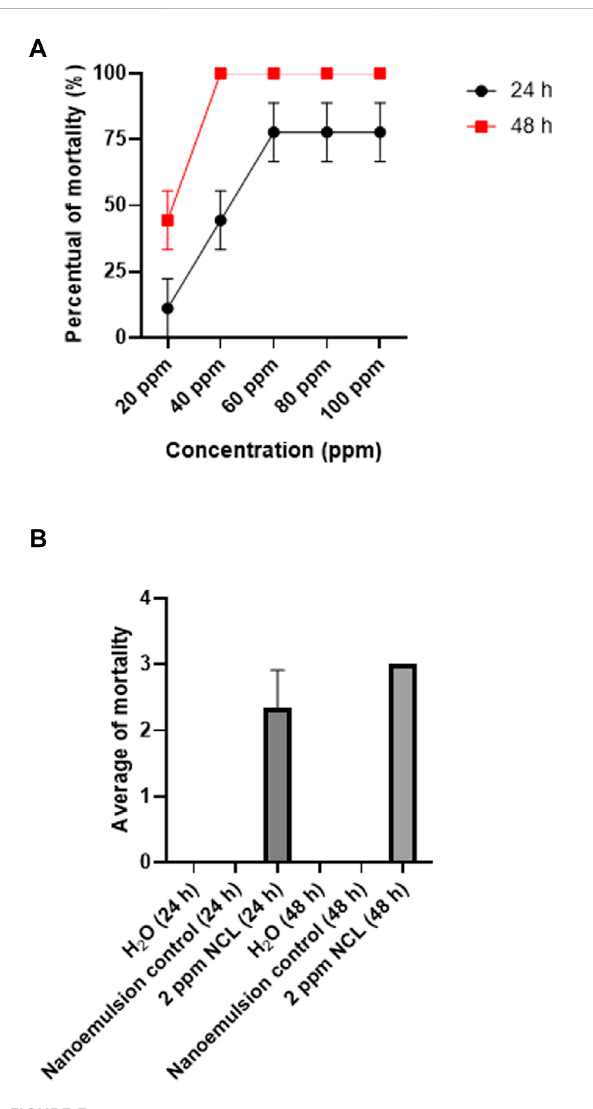
FIGURE 3 Molluskicide test on juvenile Biomphalaria glabrata for 48 h using NE (A,B) . The test was performed in triplicate on different days using 27 specimens/triplicate. These data are expressed as the mean ± S.D. Linear regression analysis, R 2 : 0.8924, p -value: